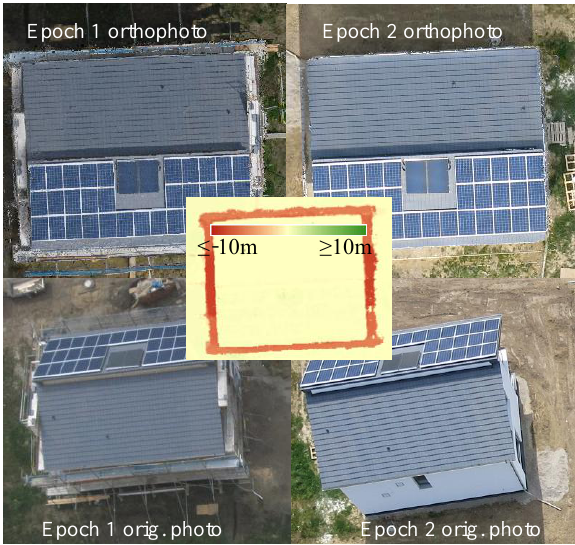
Figure 4: Dismantled scaffolding around a building Figure 5 demonstrates the possibility of observing earth mass movements. The pile of earth visible in the first epoch was distributed over the area before the images to the second epoch were